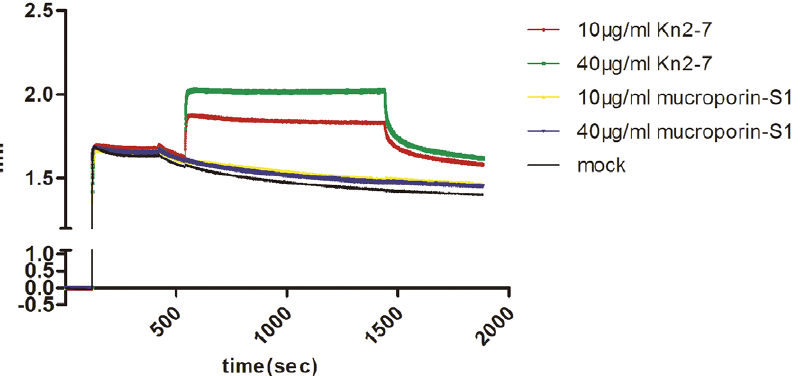
Figure 4. Direct binding of peptide Kn2-7 to HIV-1 PV. HIV-1 PV was bound and analyzed, in parallel, by five Octet APS sensors. APS sensors were pre-wet for 120 s, and then coupled with 200 m l HIV-1 PV for 300 s. After clearance of unabsorbed PV, APS sensors were associated with 10 m g/ ml and 40 m g/ml of Kn2-7 or mucroporin-S1 for 900 s (Measured in nanometers).